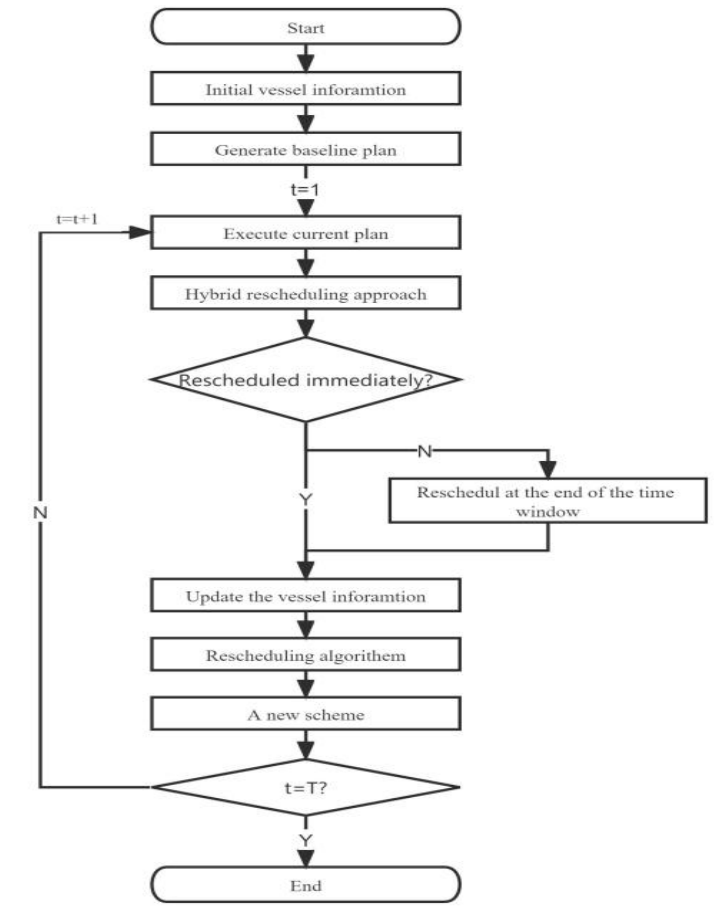
Figure 3. Rescheduling framework